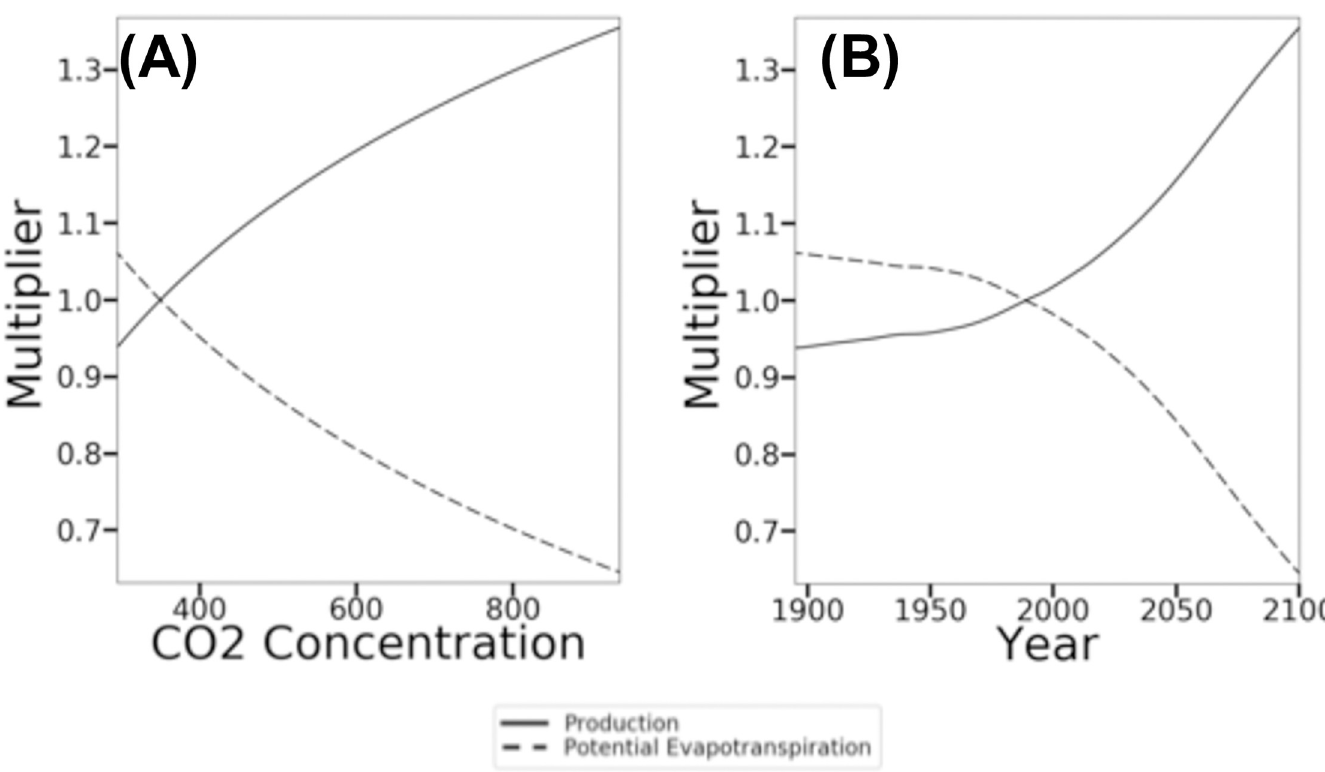
Fig 3. CO 2 fertilization effect scalar. The scalar used in MC2 to calculate production and potential evapotranspiration vs (A) atmospheric CO 2 concentration and (B) year.